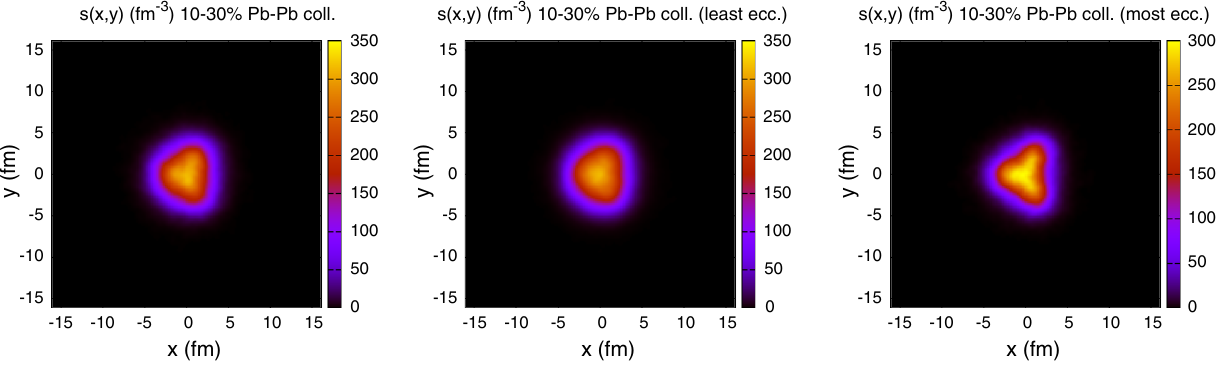
√ s NN = 5 . 02 TeV. The three panels refer to no eccentricity